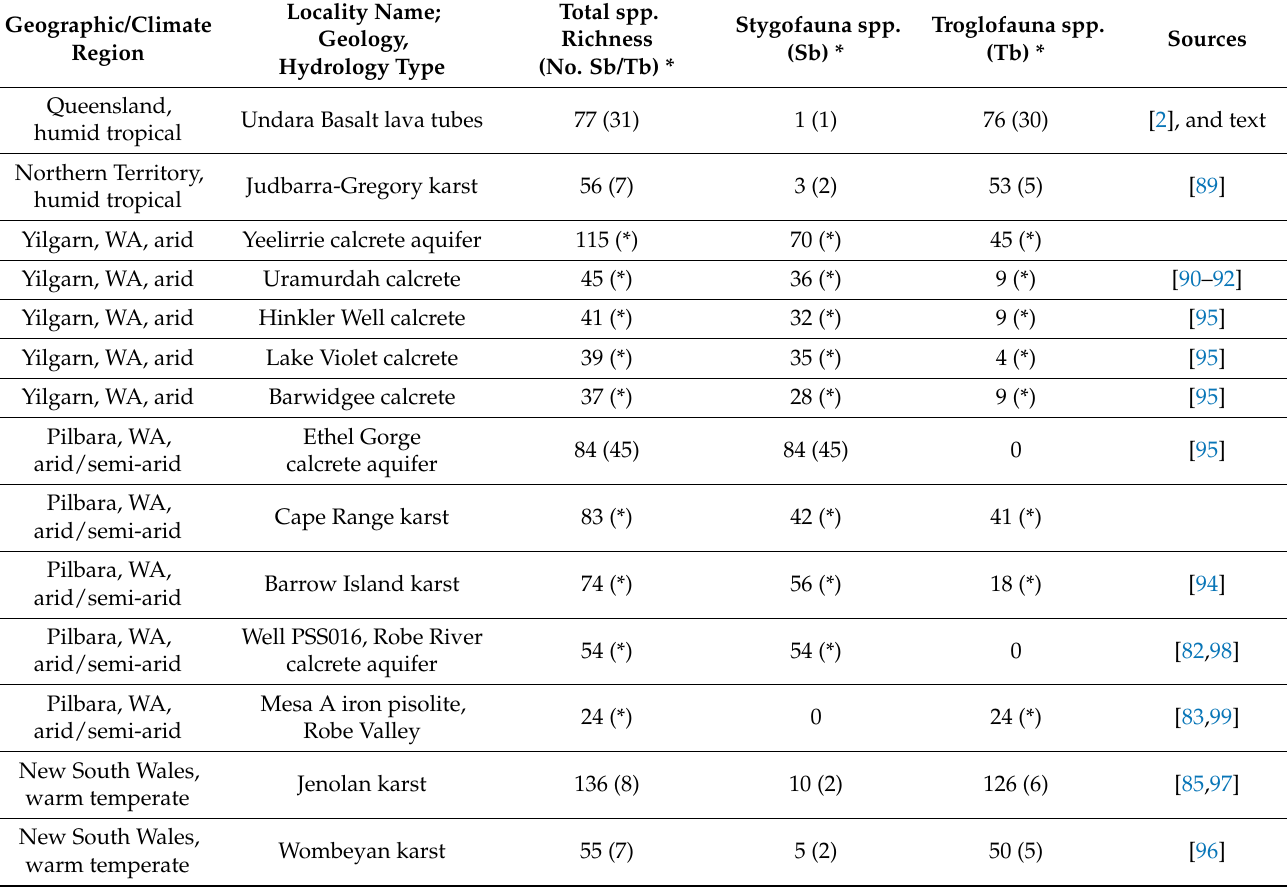
Table 4. Preliminary list of Australian hotspots (>30 obligate spp.) and regionally significant warm spots, grouped by geographic/climate region. Each locality is considered to represent a single subterranean ecosystem, characterised by geological and hydrological connectivity (excluding large-scale subterranean systems such as Nullarbor karst and Pilbara iron-ore ranges). Total species richness is the number of stygofauna and troglofauna (ecological categories combined) and the number in brackets (n) is the number of stygobionts (Sb) and troglobionts (Tb) where known. * For most localities in Western Australia (WA) the ecological status of many species remains unspecified however the majority are short-range endemics and almost certainly obligate subterranean species based on the groups